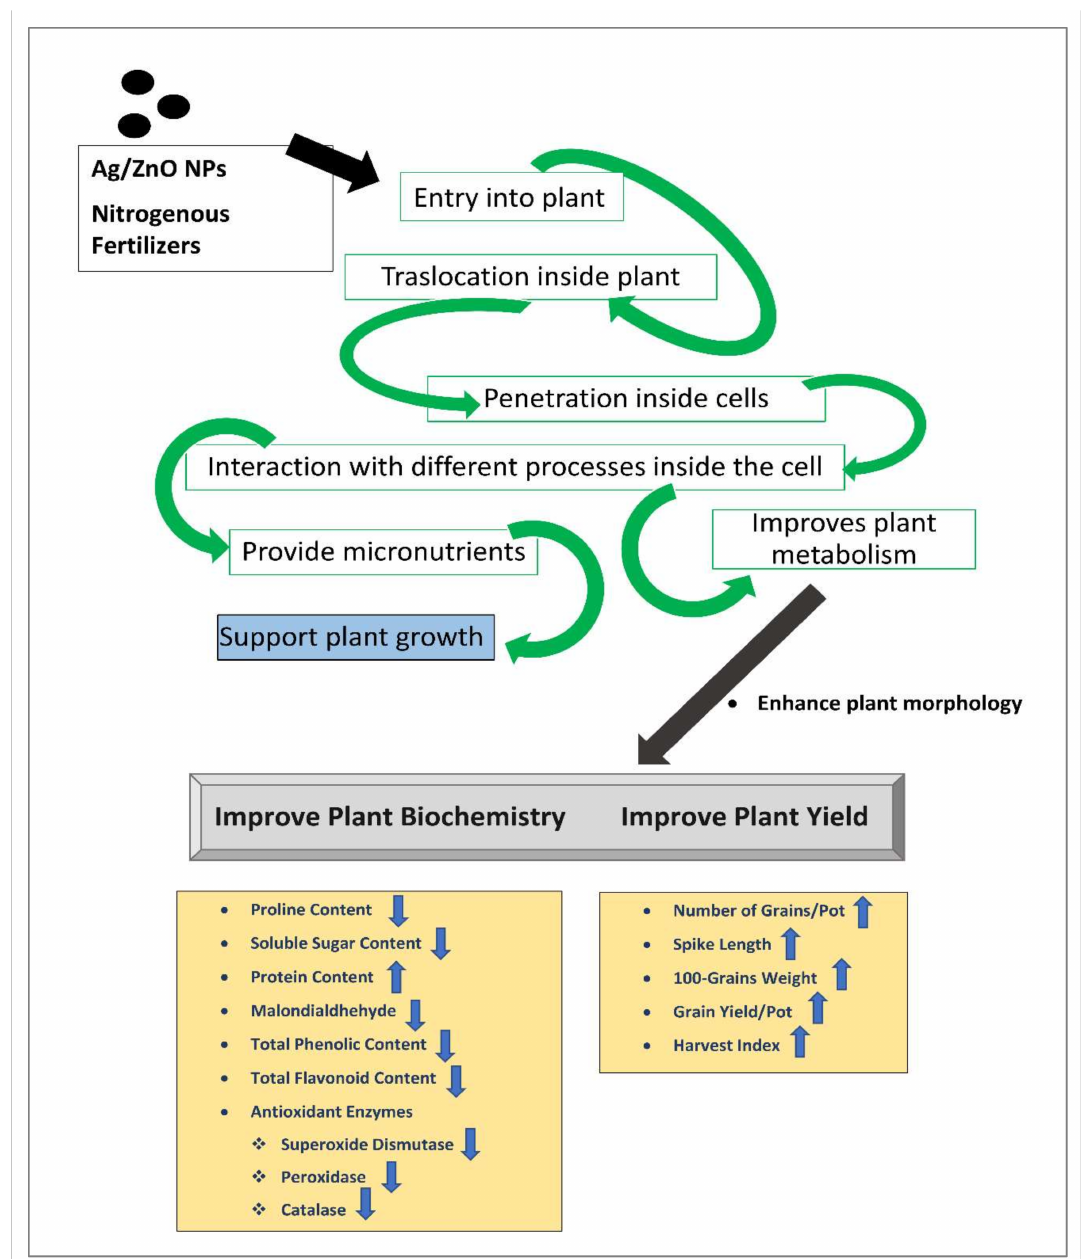
Figure 8. Overall effects of phytogenically synthesized bimetallic Ag/ZnO nanomaterials and nitrogens-based fertilizers on wheat